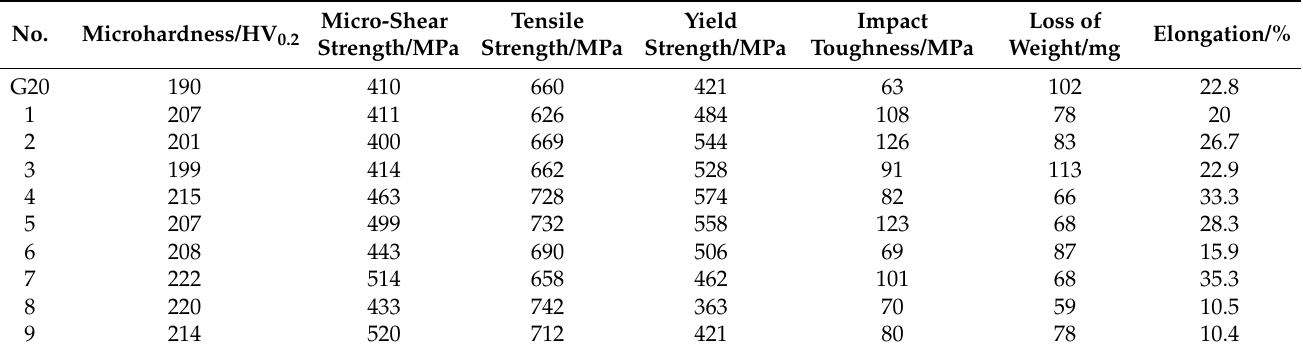
Table 6. Orthogonal tests and